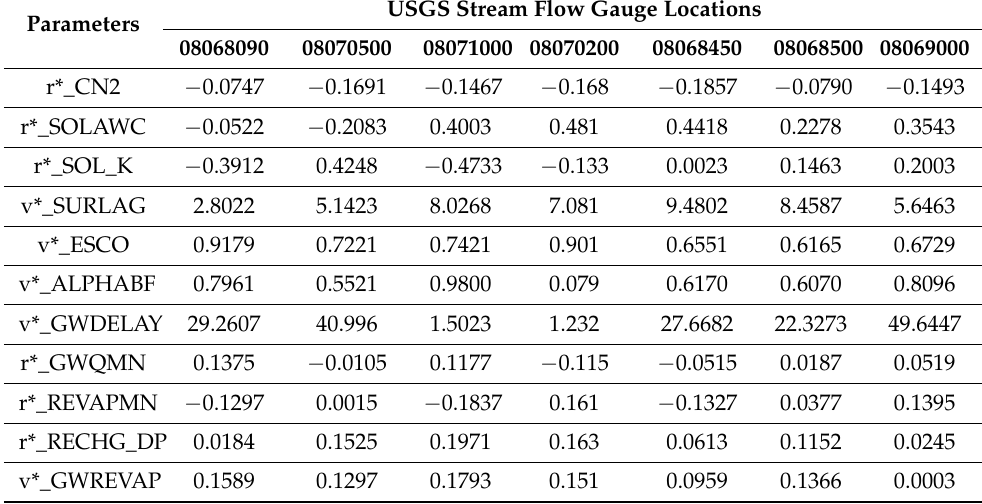
Table 2. Calibrated Model Parameters from